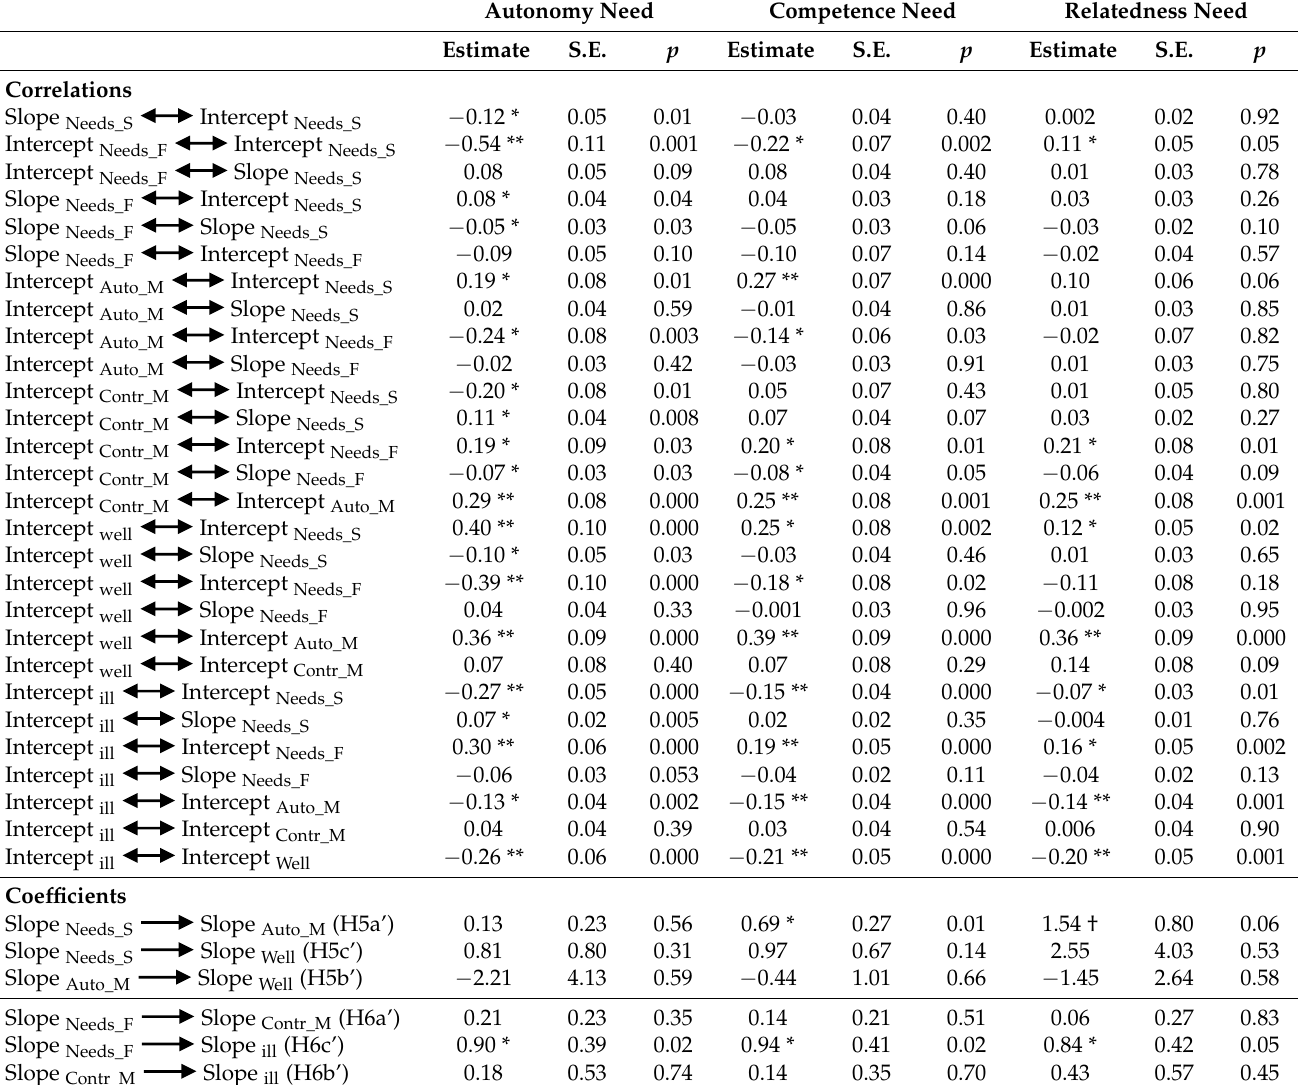
mous/Controlled Motivation . Table 5. Parameter Estimates for LGM Models: Needs Satisfaction/Frustration and Autono-